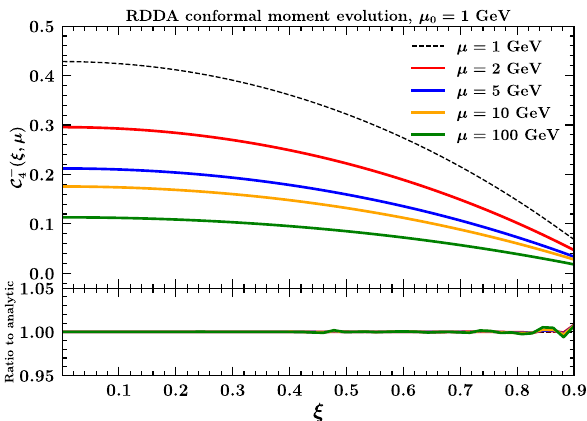
Fig. 6 Leading-order evolution of the second ( n = 4) conformal moment of the non-singlet distribution of the Radyushkin double- distribution ansatz (RDDA) described in the text. The evolution starts from μ 0 = 1 GeV up to different values of the final scale μ . The upper inset displays the moment as a function of the skewness ξ obtained by numerically solving Eq. (28) and by computing the conformal moment of the final-scale distribution by means of Eq. (75), while the bottom inset shows the ratio to the solution of Eq. (78). As in Fig. 4, the curves in the bottom inset are hardly distinguishable because they all lie on top of each